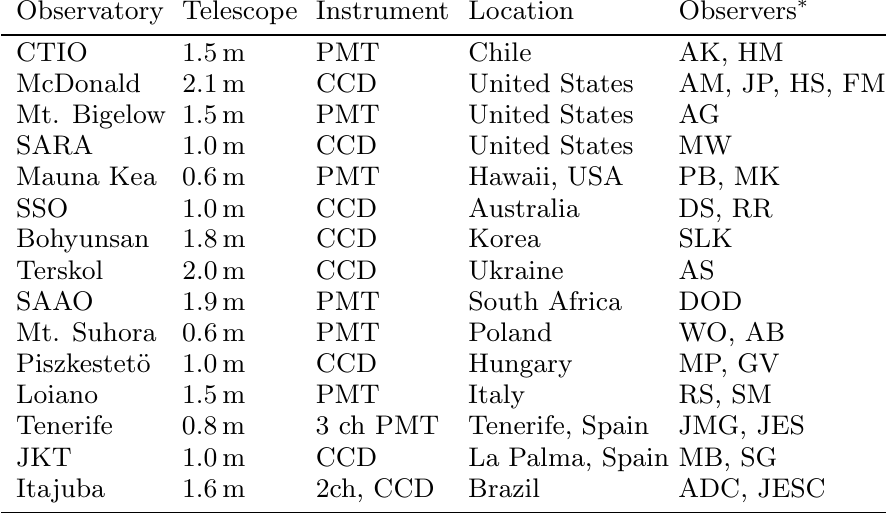
Table 2. Contributing observatories. Observatory Telescope Instrument Location Observers ∗